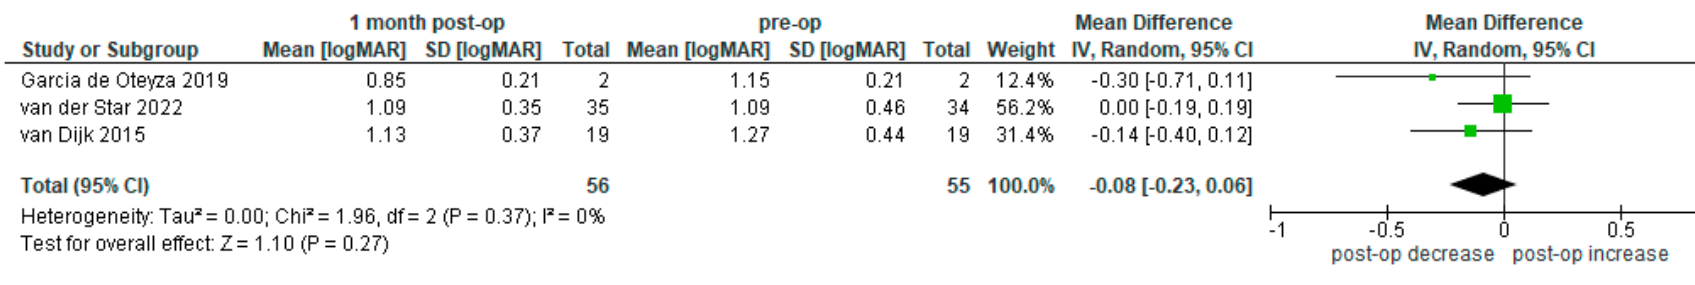
Figure A1. Di ff erence in best spectacle-corrected visual acuity across 3 studies [28,37,43].